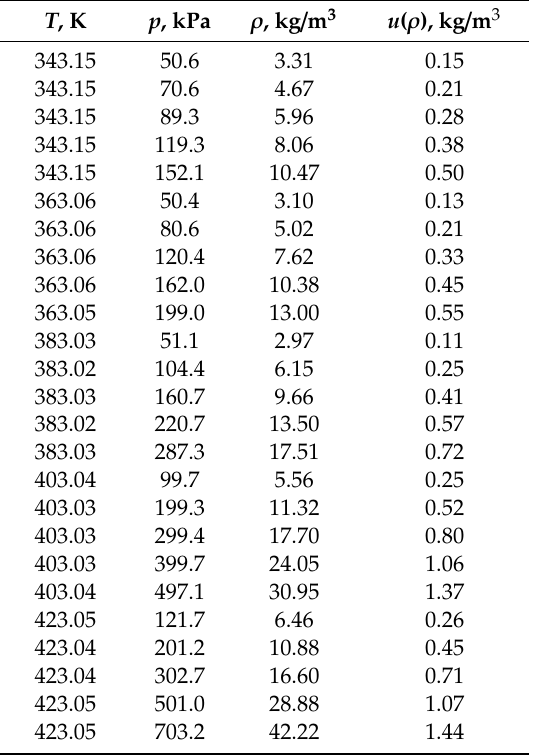
Table 8. Density data in the vapor phase for